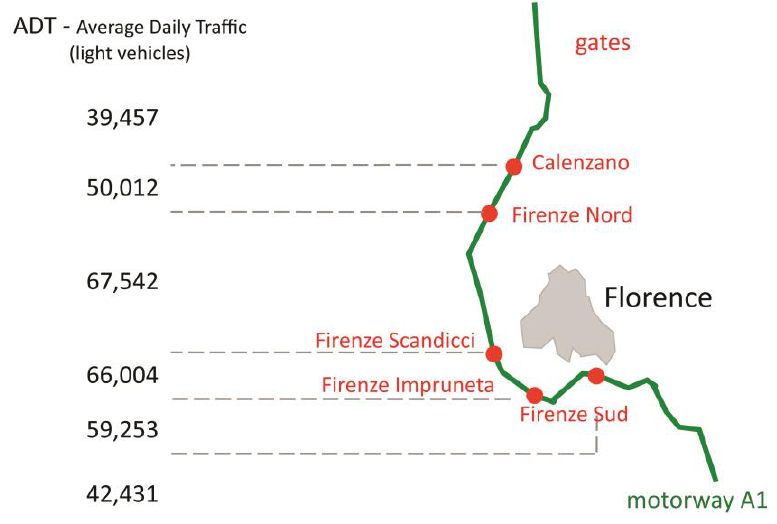
Figure 2. Traffic data (light vehicles) of motorway A1 in 2014 (source: Autostrade per l’Italia S.p.a.).